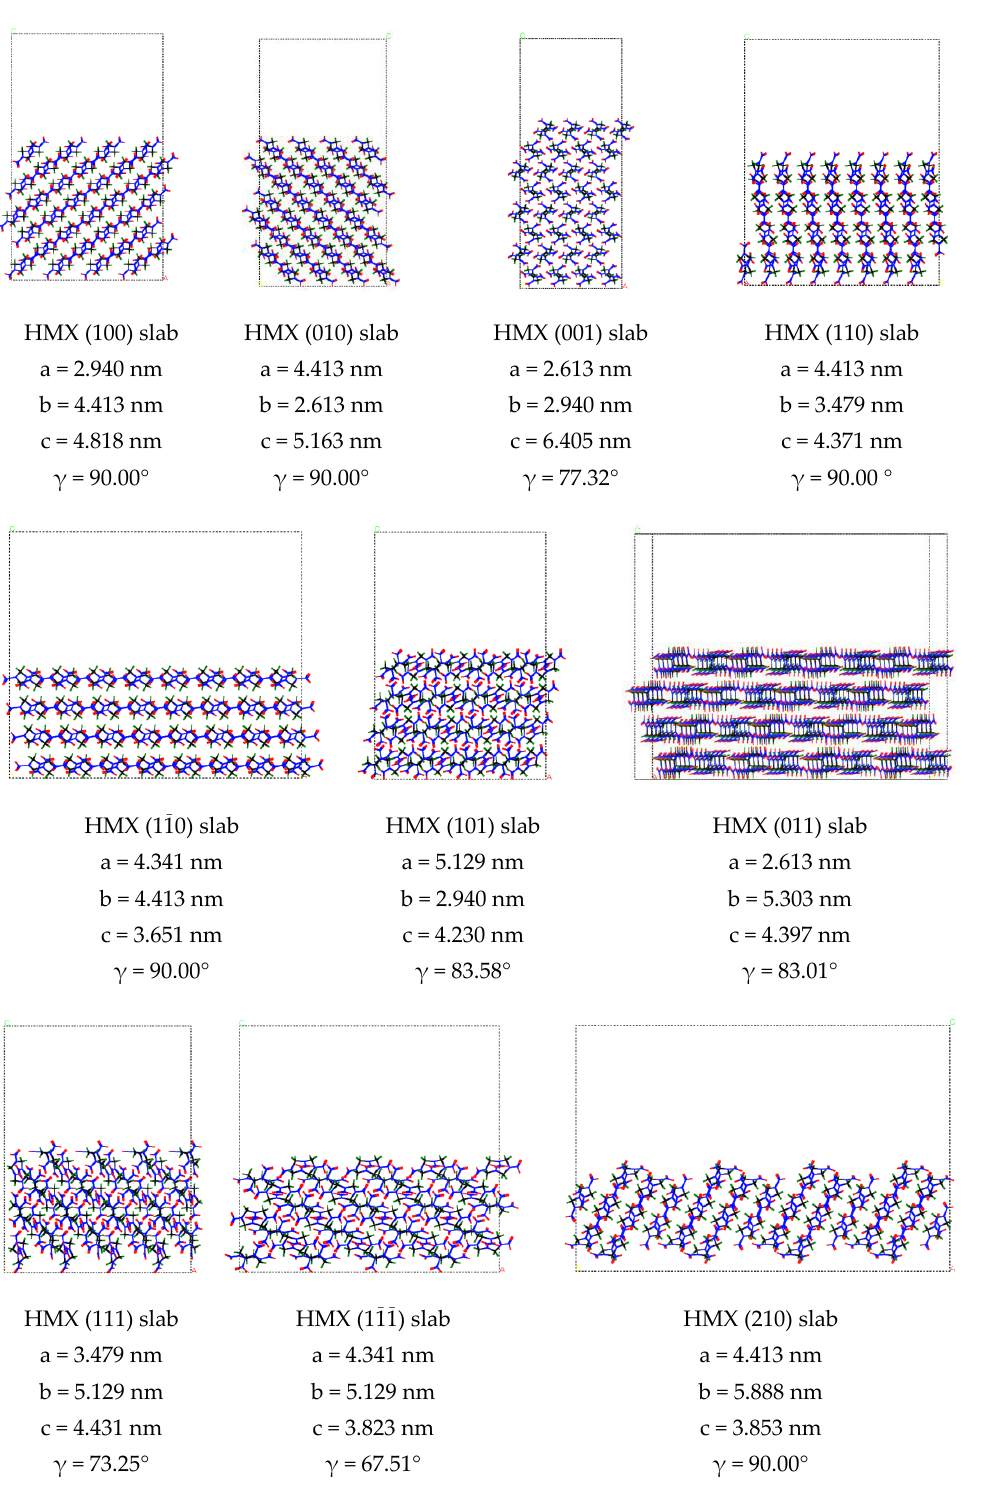
Figure 1. The slab of RDX (a) and HMX (b) crystal lattice constructed within Forcite module in Material Studio 6.